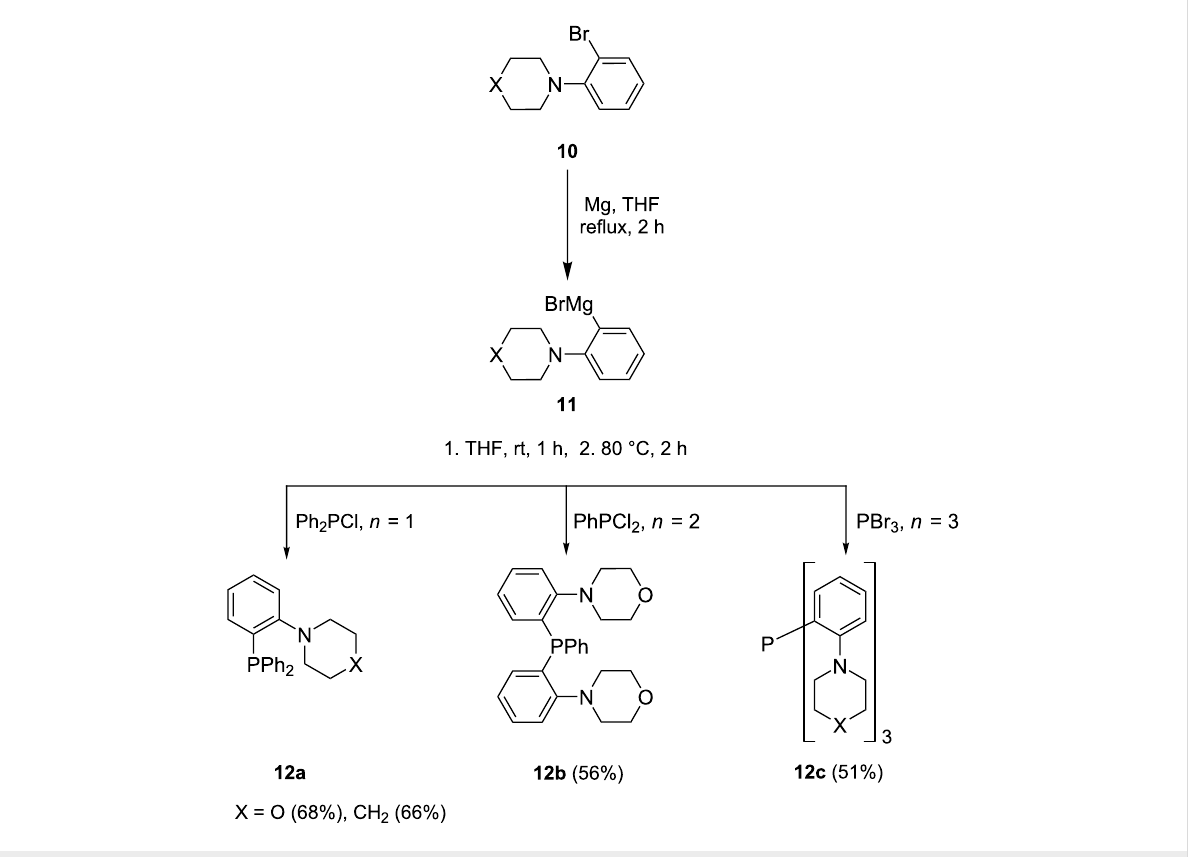
Scheme 2: Synthesis of piperidyl- and oxazinylphosphine